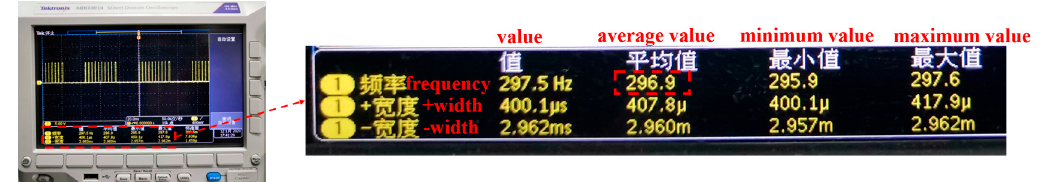
Figure 9. Pulse frequency captured by oscilloscope